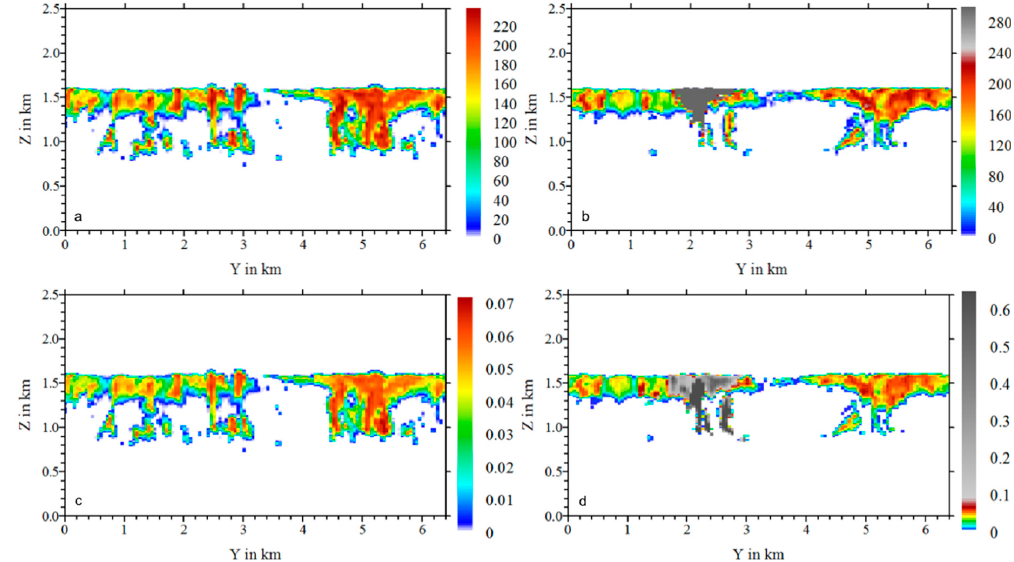
Figure 10. Vertical cross section of the drop number concentration (cm − 3 ): ( a ) without the plume; ( b ) with the plume; vertical cross section of the aerosol particle mass in drops (µg m − 3 ): ( c ) without the plume; ( d ) with the plume; after 260 min along the cross section indicated in Figure 9 and projected onto the Y-axis.